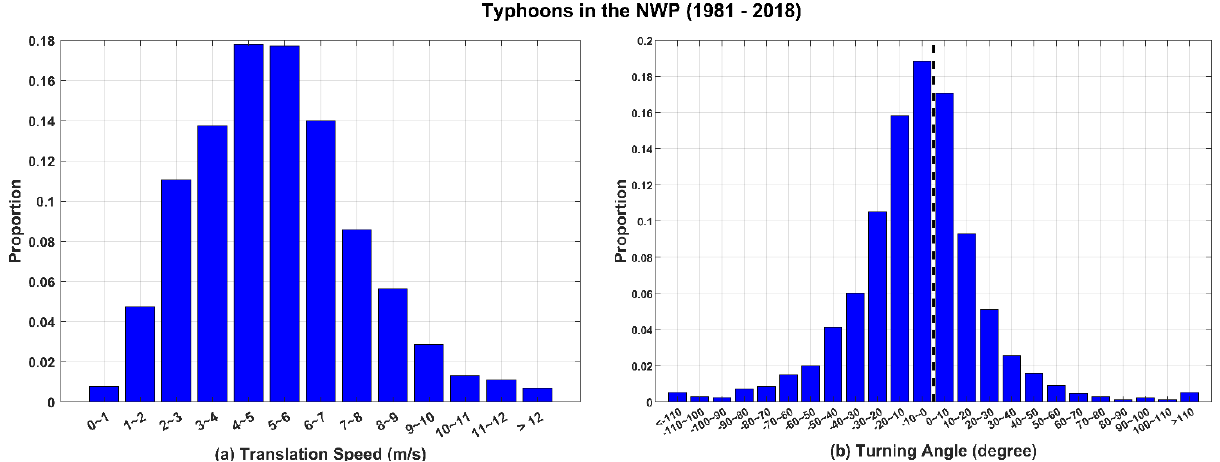
Figure 10. Distribution of typhoon ( a ) translation speed and ( b ) turning angle in the NWP during the 40 years from 1981 to 2018.